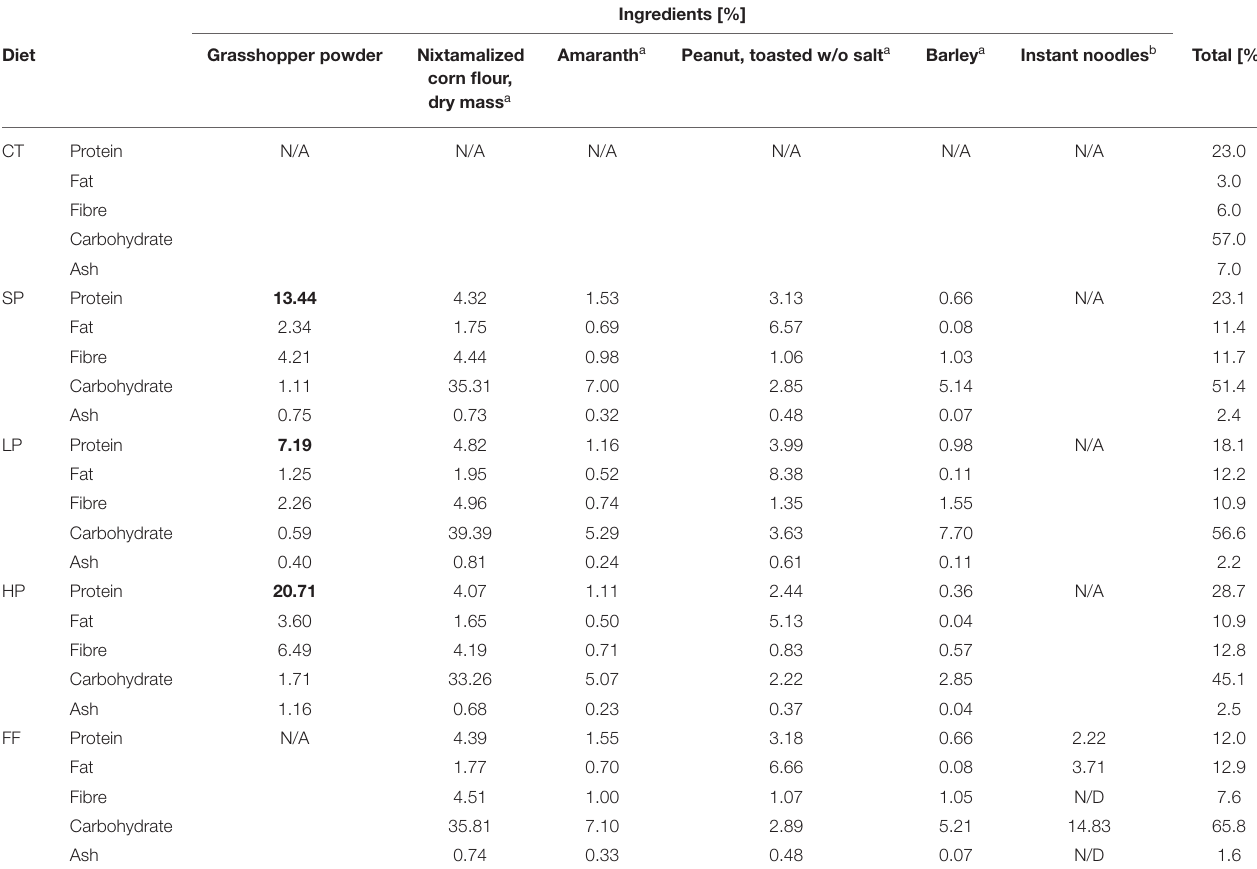
TABLE 1 | Nutritional composition of each treatment (% in 100g of dry processed